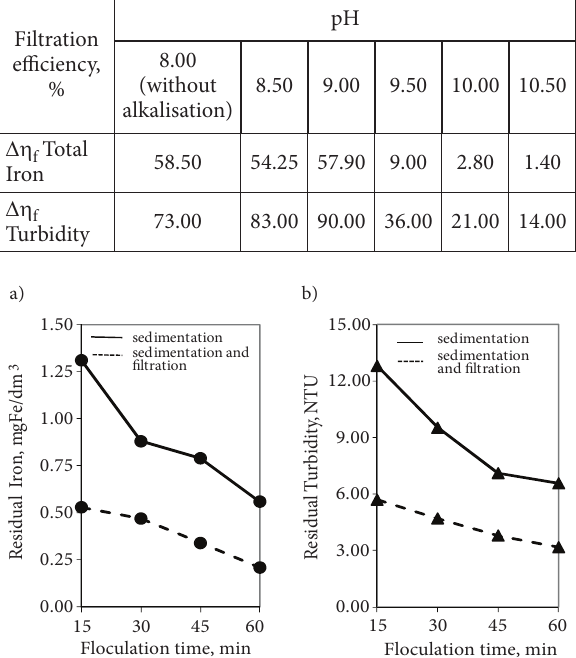
Table 3. Effect of alkalinisation with calcium hydroxide in the